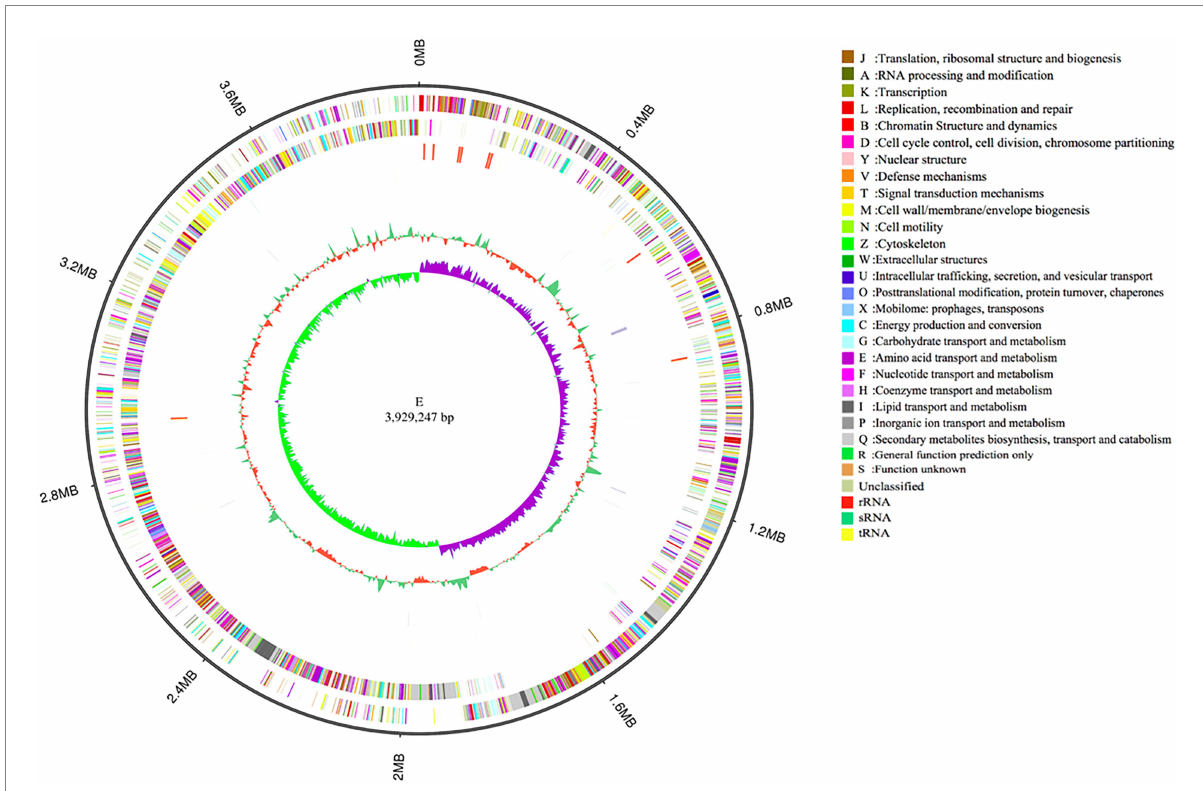
FIGURE 8 Genomic completion map of strain E. The size and scale of genome is shown in the outermost circle. Outer to inner rings represent forward and reverse strand genes annotated according to COG, forward and reverse strand ncRNA, repeat, GC content and GC-SKEW.